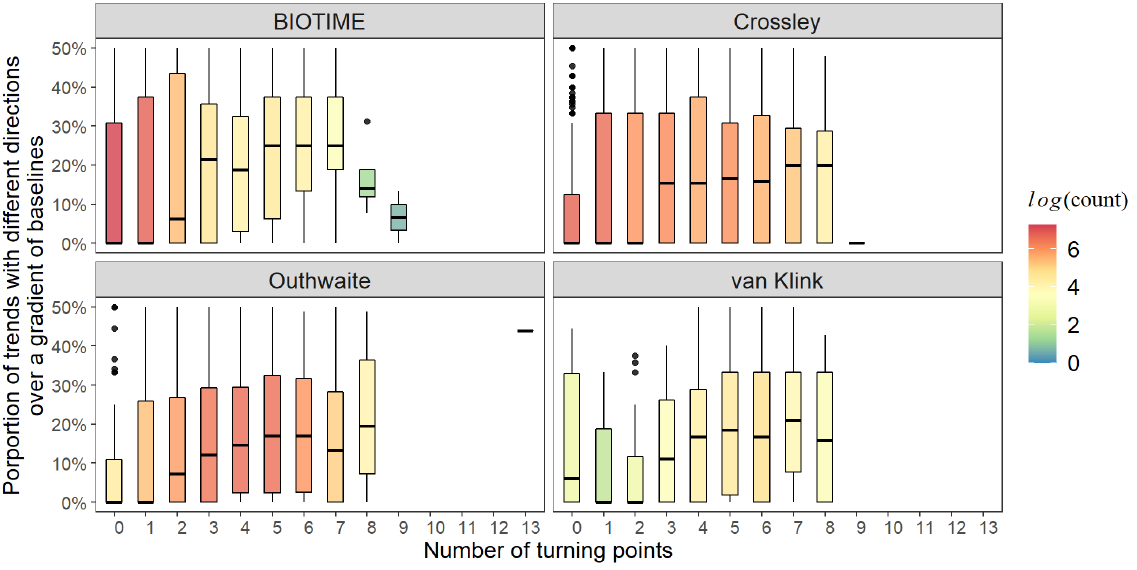
Figure S6: Same figure as in the main text (Figure 3b), but for each source dataset. Proportion of abundance trends from truncated time series with different directions (positive vs. negative), as a function of the number of turning points in the corresponding original time series. Boxplots represent minimum and maximum values (bottom and top of vertical lines), first and third quartiles (Q1 and Q3, bottom and top of boxes) and median (thick horizontal lines); colours indicate sample size (number of original time series). Points with values outside of the range [Q1-1.5(Q3-Q1), Q3+1.5(Q3-Q1)] are considered as outliers and represented as full